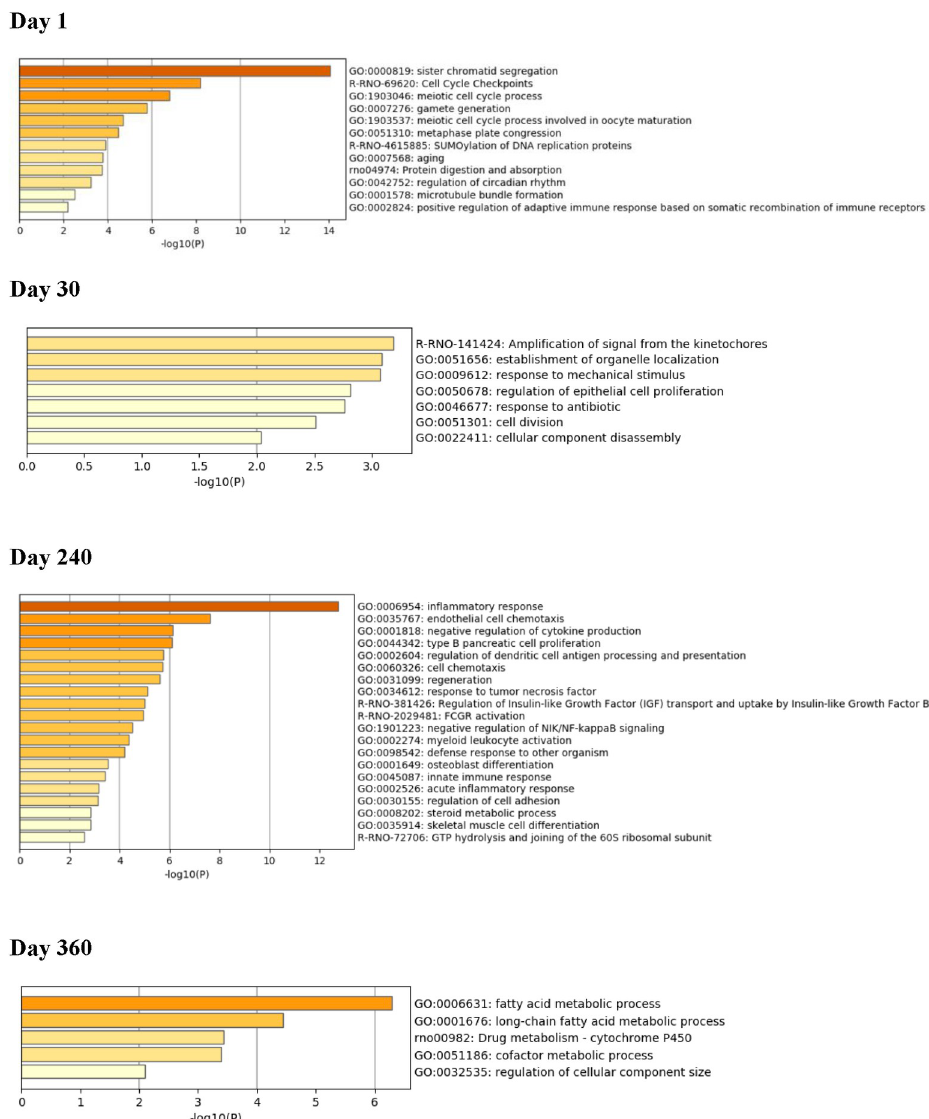
Fig 16. Enrichment analysis for down-regulated genes in hearts. Functional gene set enrichment analysis (GSEA) of top down-regulated genes was performed for tissues collected at Days 1, 30, 240, and 360 post-exposures. The X-axis is the negative log-transformed p-value of the enriched terms. The darker the color, the more statistically significant the enriched term (pathways, GO terms, etc.). Groups of rats exposed to air (na ï ve, n = 6/each timepoint group) or ISO (n = 5/Day 1 group, and n = 6/Day 30, 240, and 360 groups) were